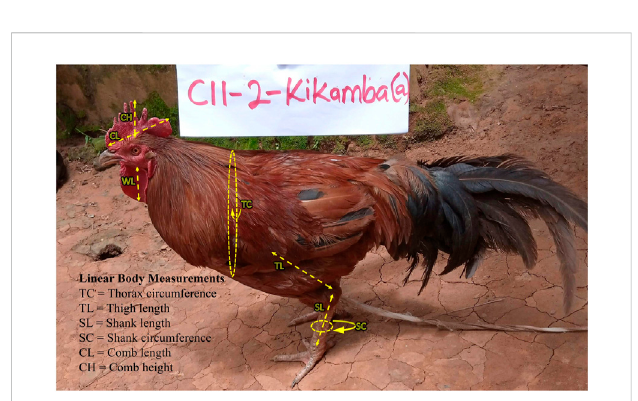
FIGURE 2 Linearmeasurements(incm)oftheindigenouschickensinUganda, as described by AU-IBAR